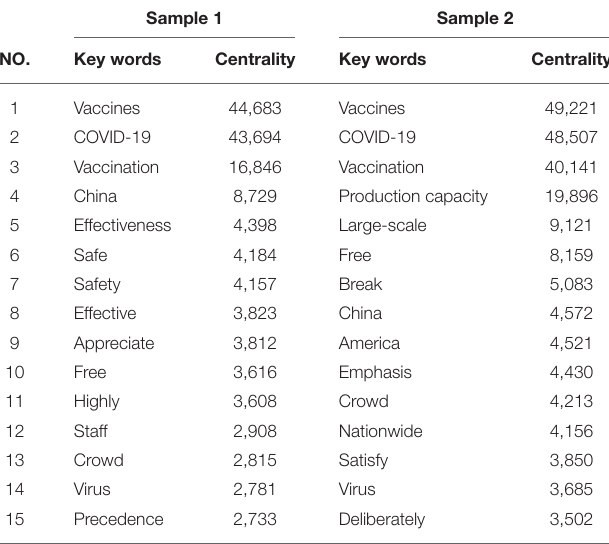
TABLE 1 | The degree centrality of keywords in two semantic networks. Sample